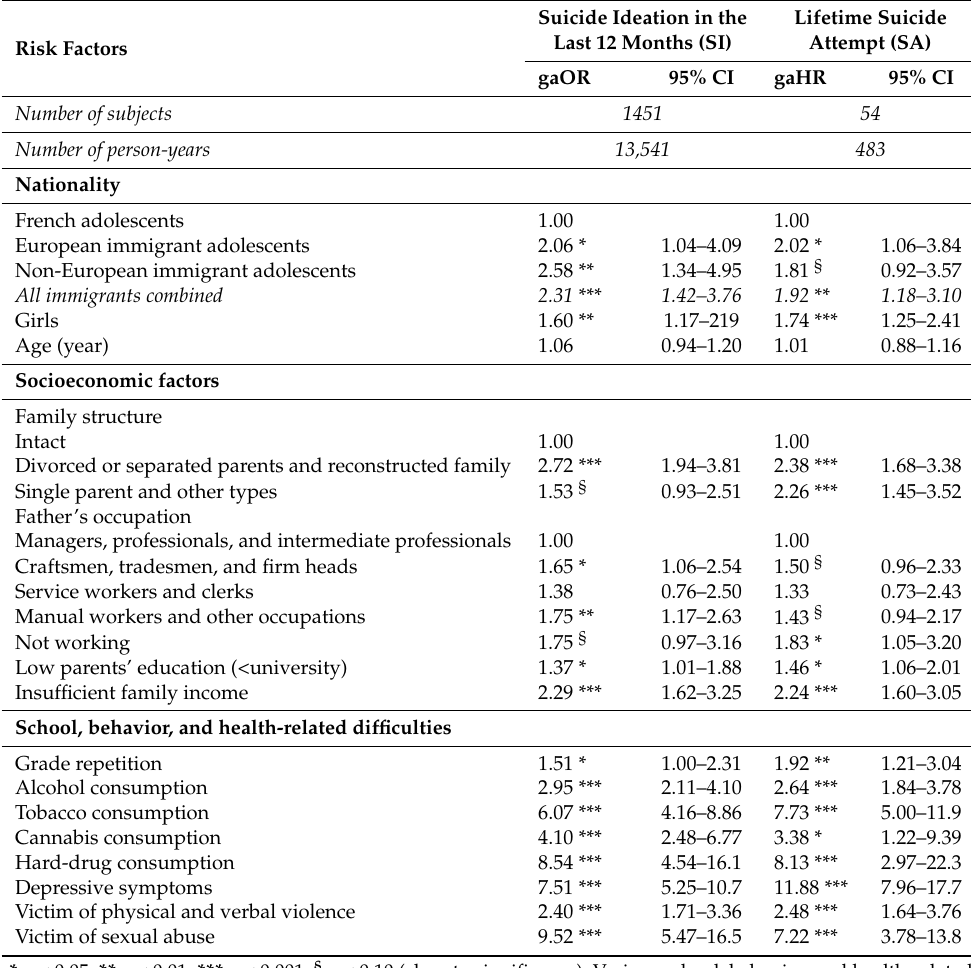
Table 3. Factors associated with suicide ideation and suicide attempt: gender-age-adjusted odds ratio (gaOR) or hazard ratio (gaHR) and 95% confidence interval